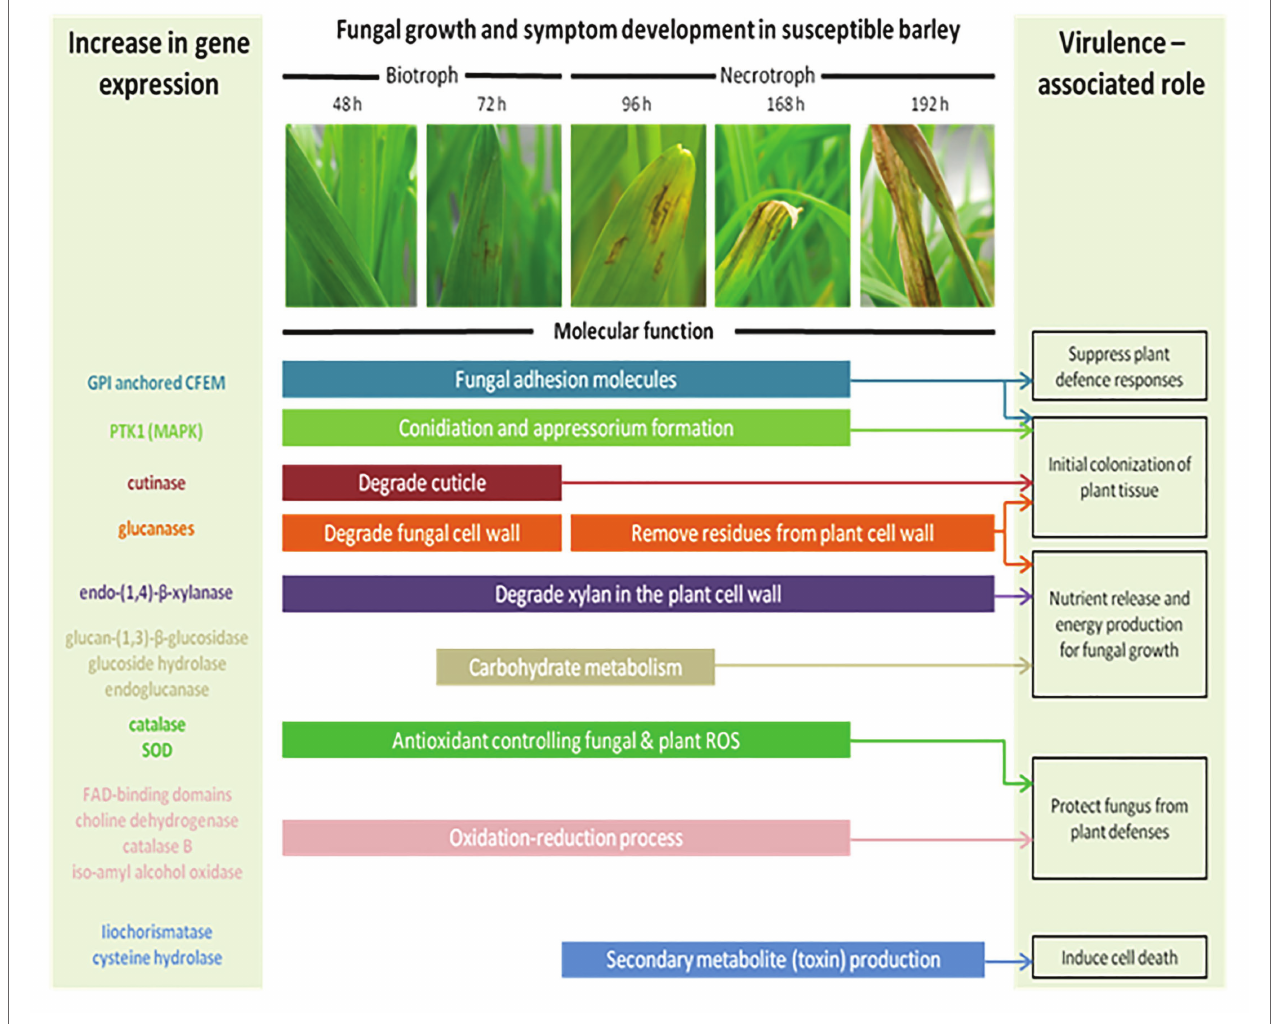
FIGURE 7 | The schematic model of the fungal growth and symptoms’ development in a susceptible barley leaf. Each enzyme occurs at a specific time of infection. At 24 h, the spores germinate and form an appressorium through the plant epidermis supposing a biotrophic stage. By 96 h, P. teres is growing inside the barley leaf and develops chlorosis and necrosis suggesting a necrotroph stage. Colored bars represent the genes expressed during the plant/pathogen interaction and describe their molecular function(s) (Inspired from Ismail and Able,